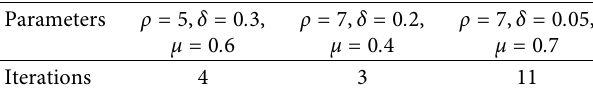
Table 4: Algorithm 2 (numerical results).